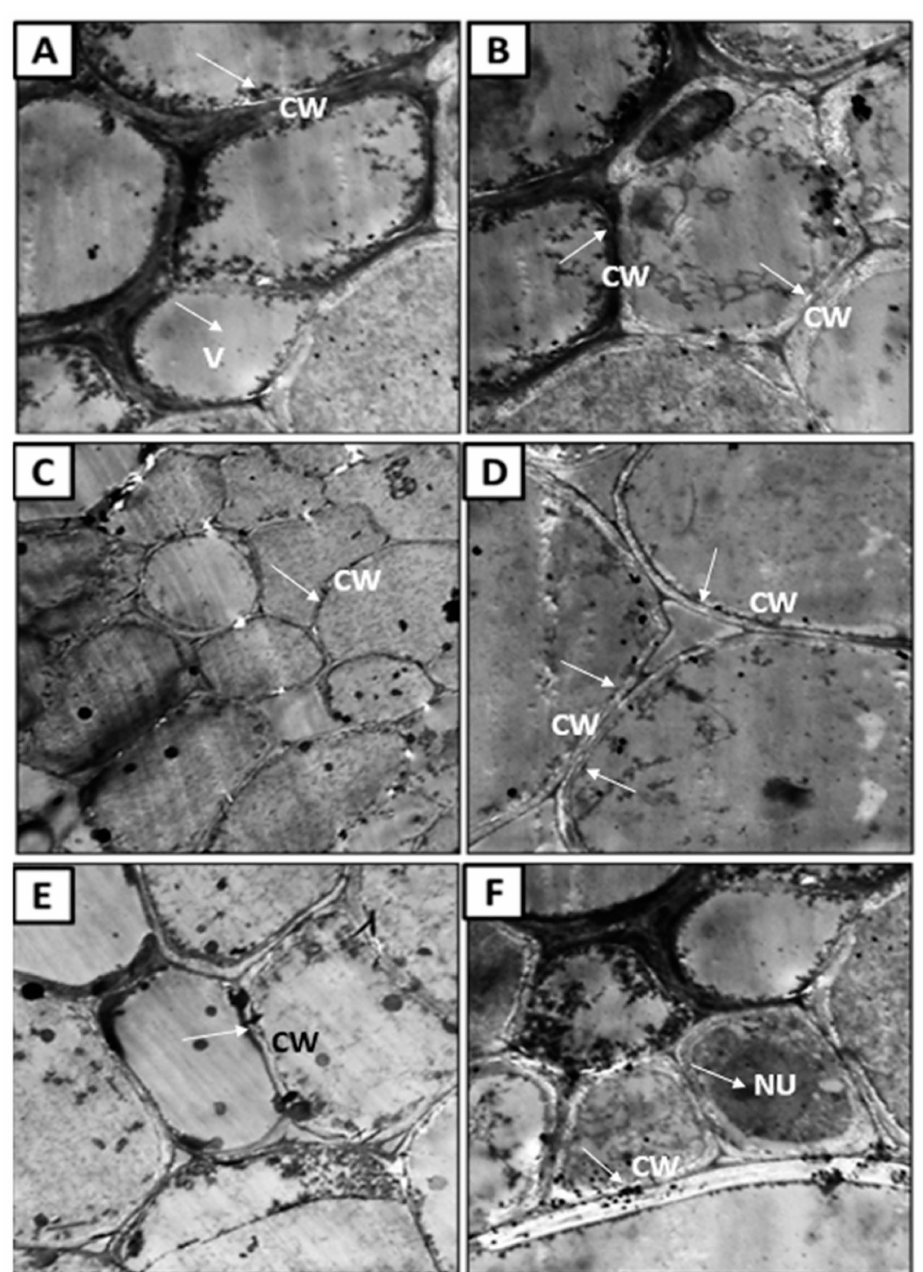
Figure 10. Ultra-micrograph section of corn ( Zea mays L.) showing healthy root cells ( A,B ), where thickened cell wall (CW) is observed compared with untreated, infected sample. There was a notice- able lack in the differentiation (LD) of the cells, cracking, and lysis in the cell wall and destruction in the nucleus ( C,D ); also, a presence of thickening in the cell wall (CW) was noticed in treated sample ( E,F